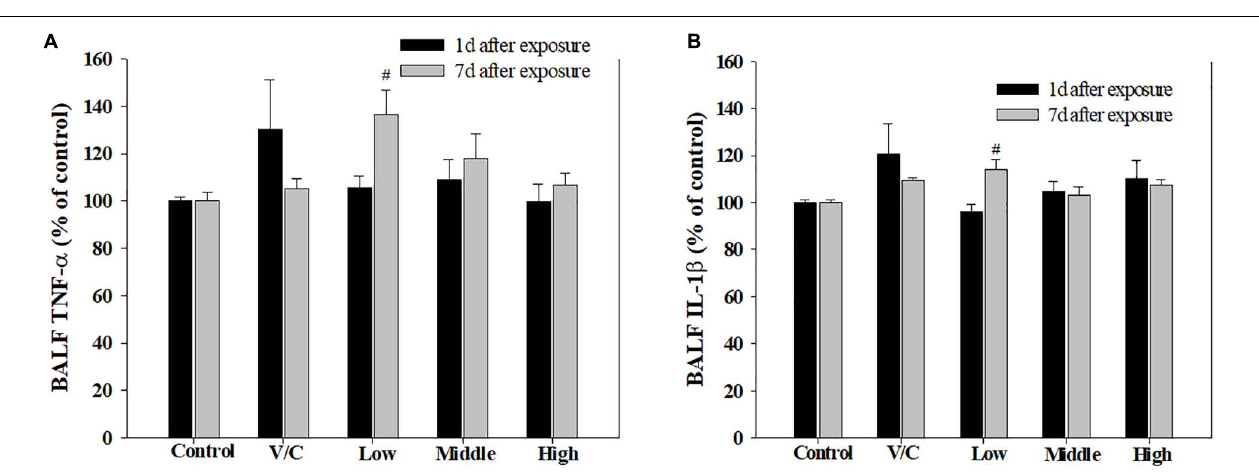
FIGURE 10 | Changes in inflammatory cytokines induced by repeated inhalation of a mixture of SM and PG for 2 weeks in male rats. (A) Tumor necrosis factor-alpha (TNF- α ), (B) interleukin-1beta (IL-1 β ) in BALF. The values are presented as the mean ± SE (one-way ANOVA followed by Tukey’s multiple comparison test, # P < 0.05 vs.